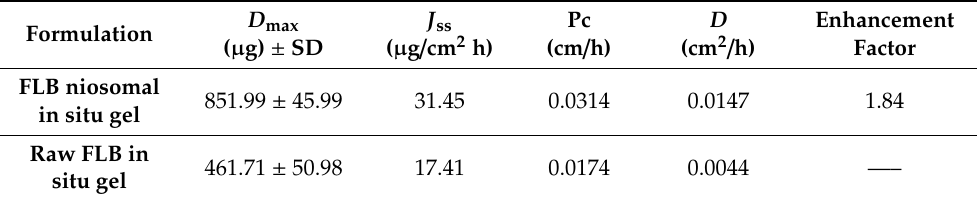
Table 5. Ex vivo permeation parameters of intra-nasal in situ gel loaded with optimized FLB niosomes compared to raw FLB in situ gel.